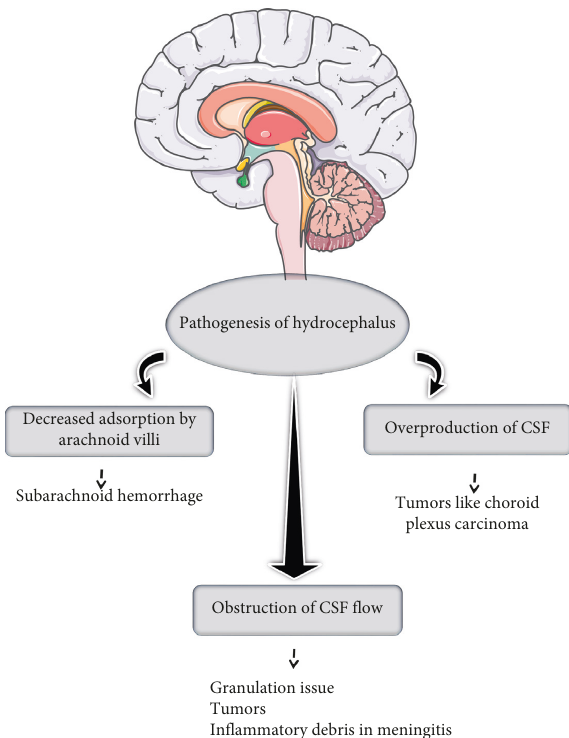
Figure 2: Pathogenesis of hydrocephalus. The ways of formation and details are explained.